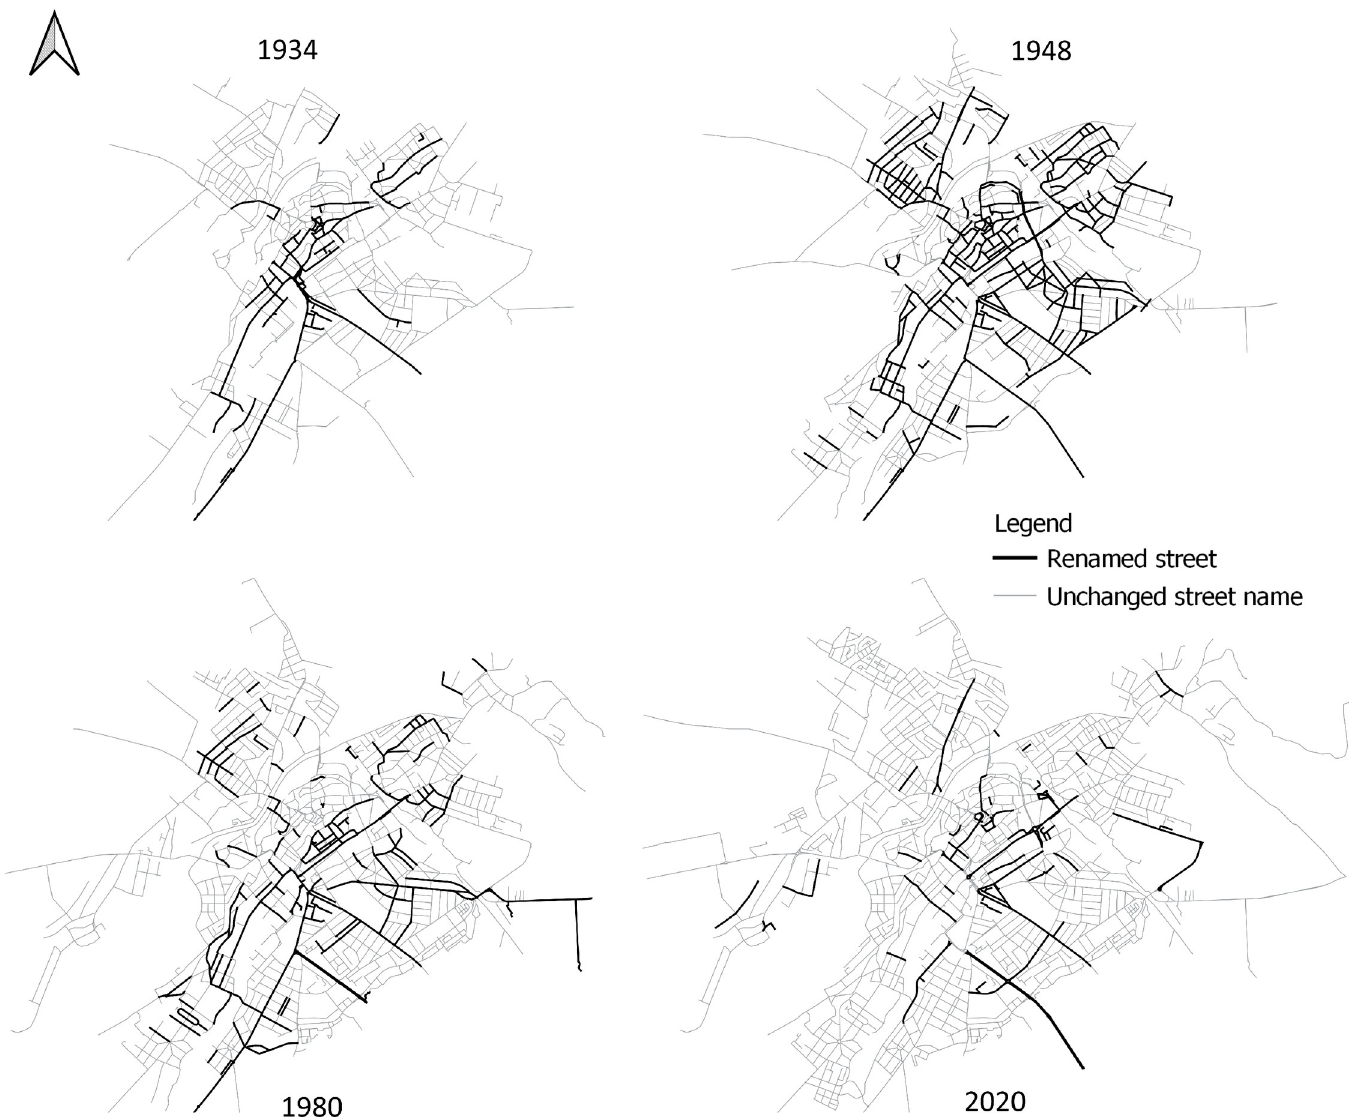
Fig 4. Topography of toponymic change in 1934, 1948, 1980, and